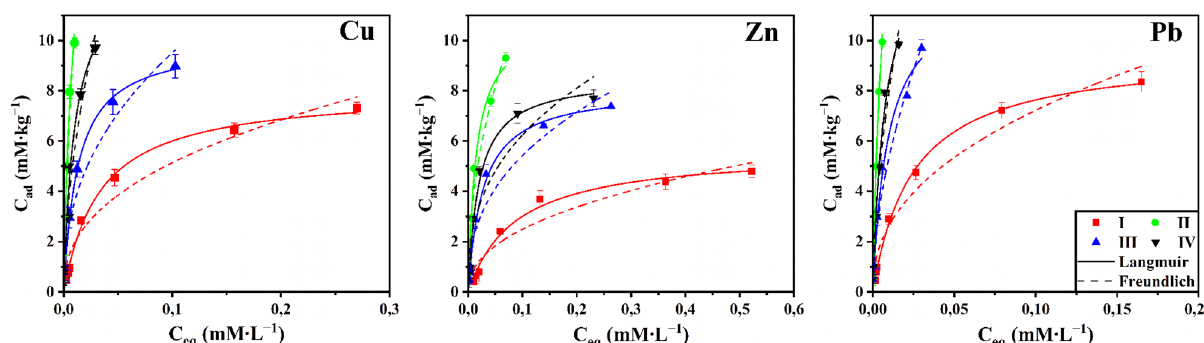
Figure 6. Adsorption isotherms of HM by soil in pure form (I) and soil with different biochars (soil + Wood biochar (II), soil + Sunflower husk biochar (III), soil + Rice husk biochar